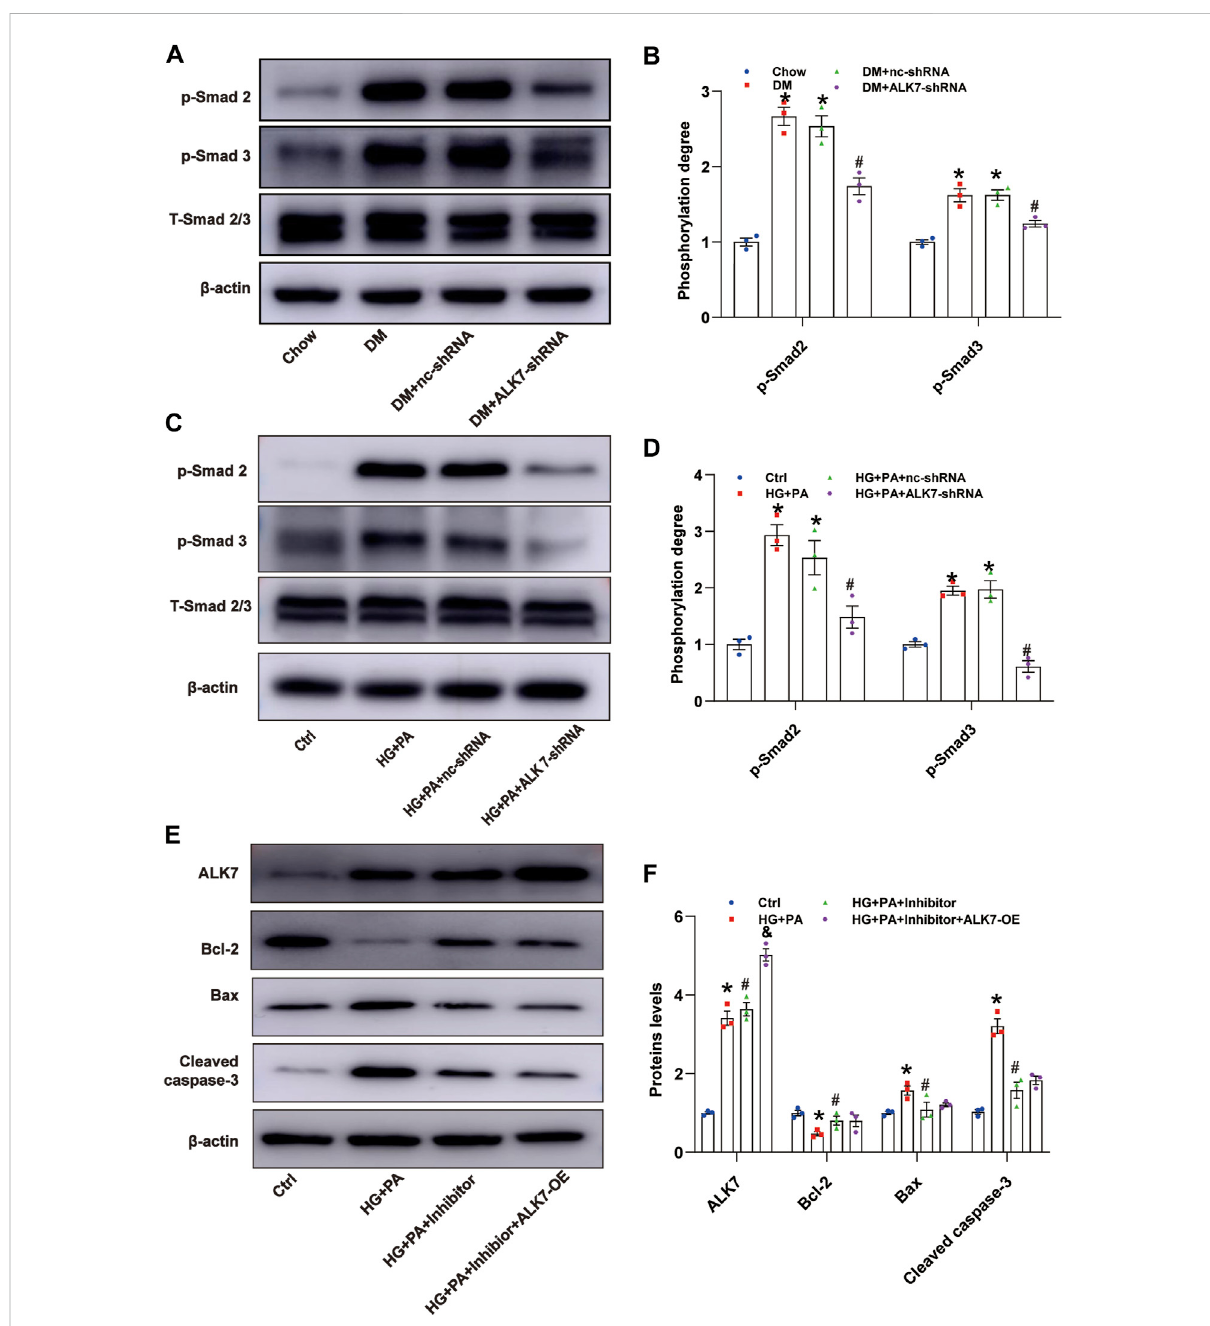
ALK7 promoted VSMC apoptosis via Smad2/3 signaling. (A – B) . The total and phosphorylation of Smad2 and Smad3 in the aortas with atheroscleroticplaquesofdiabetic miceweredeterminedbywesternblot. n =3pergroup. * p < 0.05vs.theChowgroup, # p < 0.05vs.theDM+nc- shRNAgroup. (C – D) .ThetotalandphosphorylationofSmad2andSmad3inVSMCsco-treatedwithHGandPAweredeterminedbywesternblot. n = 3 per group. * p < 0.05 vs. the control group, # p < 0.05 vs. the HG + PA + nc-shRNA group. (E – F) . The protein level of ALK7, Bcl-2, Bax,